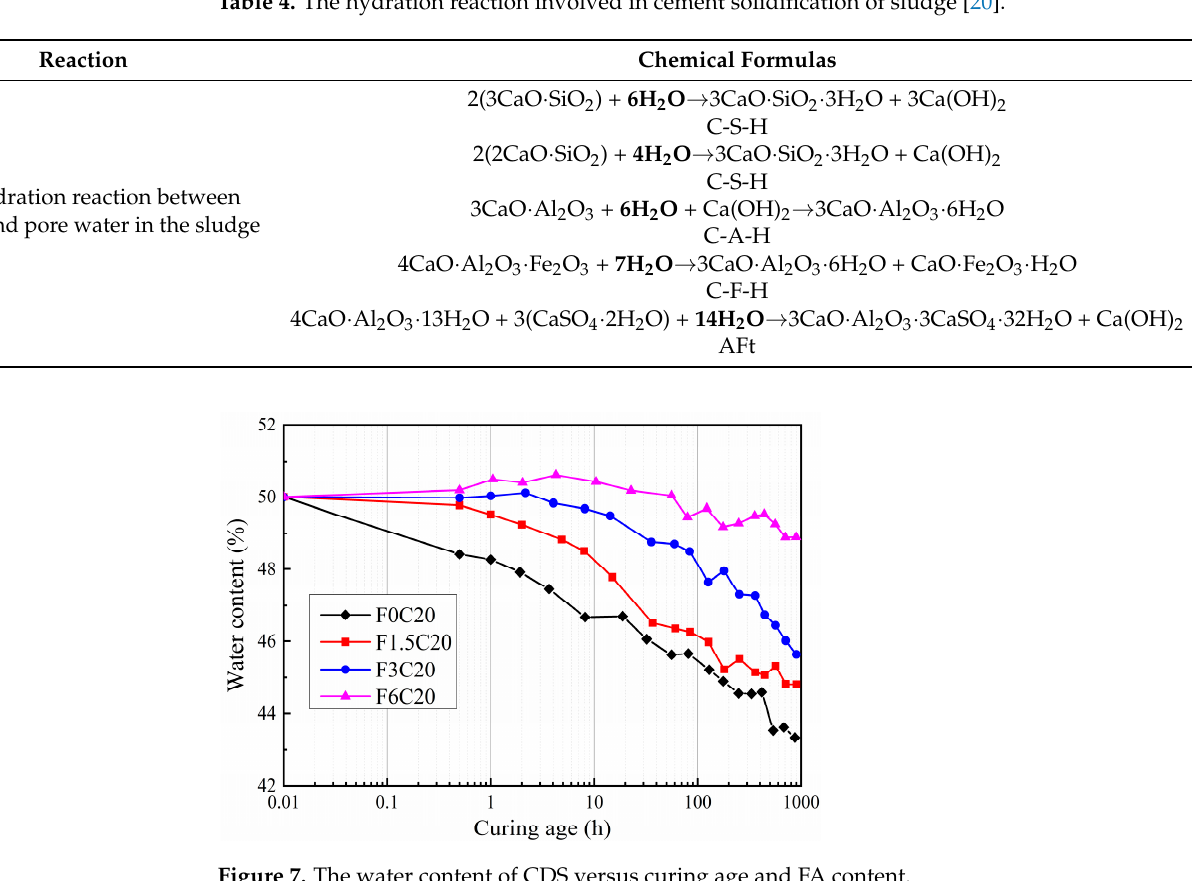
Table 4. The hydration reaction involved in cement solidification of sludge [20].